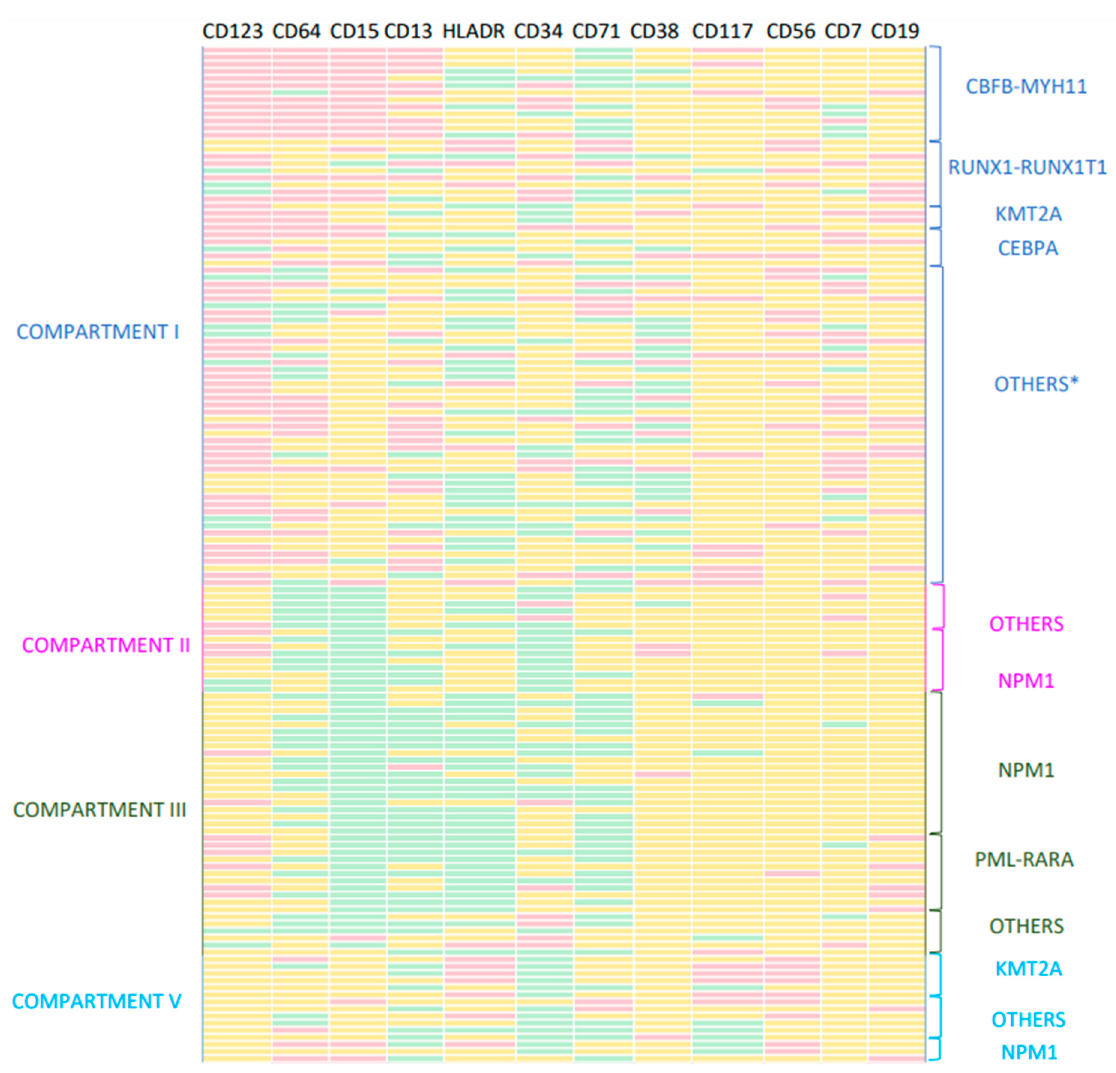
Figure 5. Immunophenotypic profiles in the different subtypes of the AML-WHO classification. The intensity of expression for the mainly altered antigens (represented in columns) is represented in yellow, red or green depending on whether it is a normal expression, overexpression or under- expression, respectively. * In compartment 1, the group “others” included RUNX1 mutated, BCR-ABL, DEKNUP, NPM1, MDS-related changes, therapy-related myeloid neoplasms and NOS cases. In the remaining compartments the group “others” included only NOS and MDS-related changes cases.